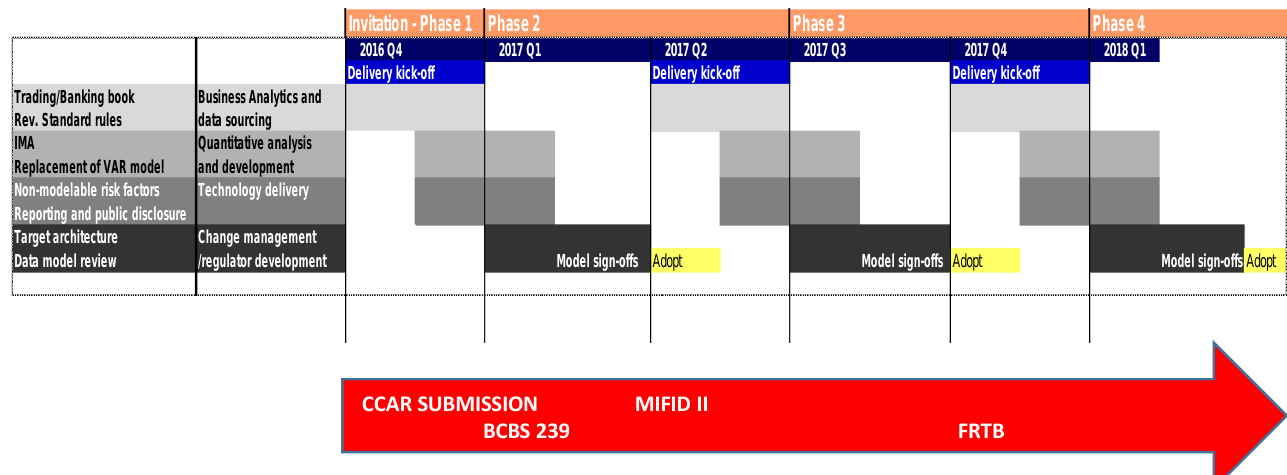
Figure 7. Possible timeline of